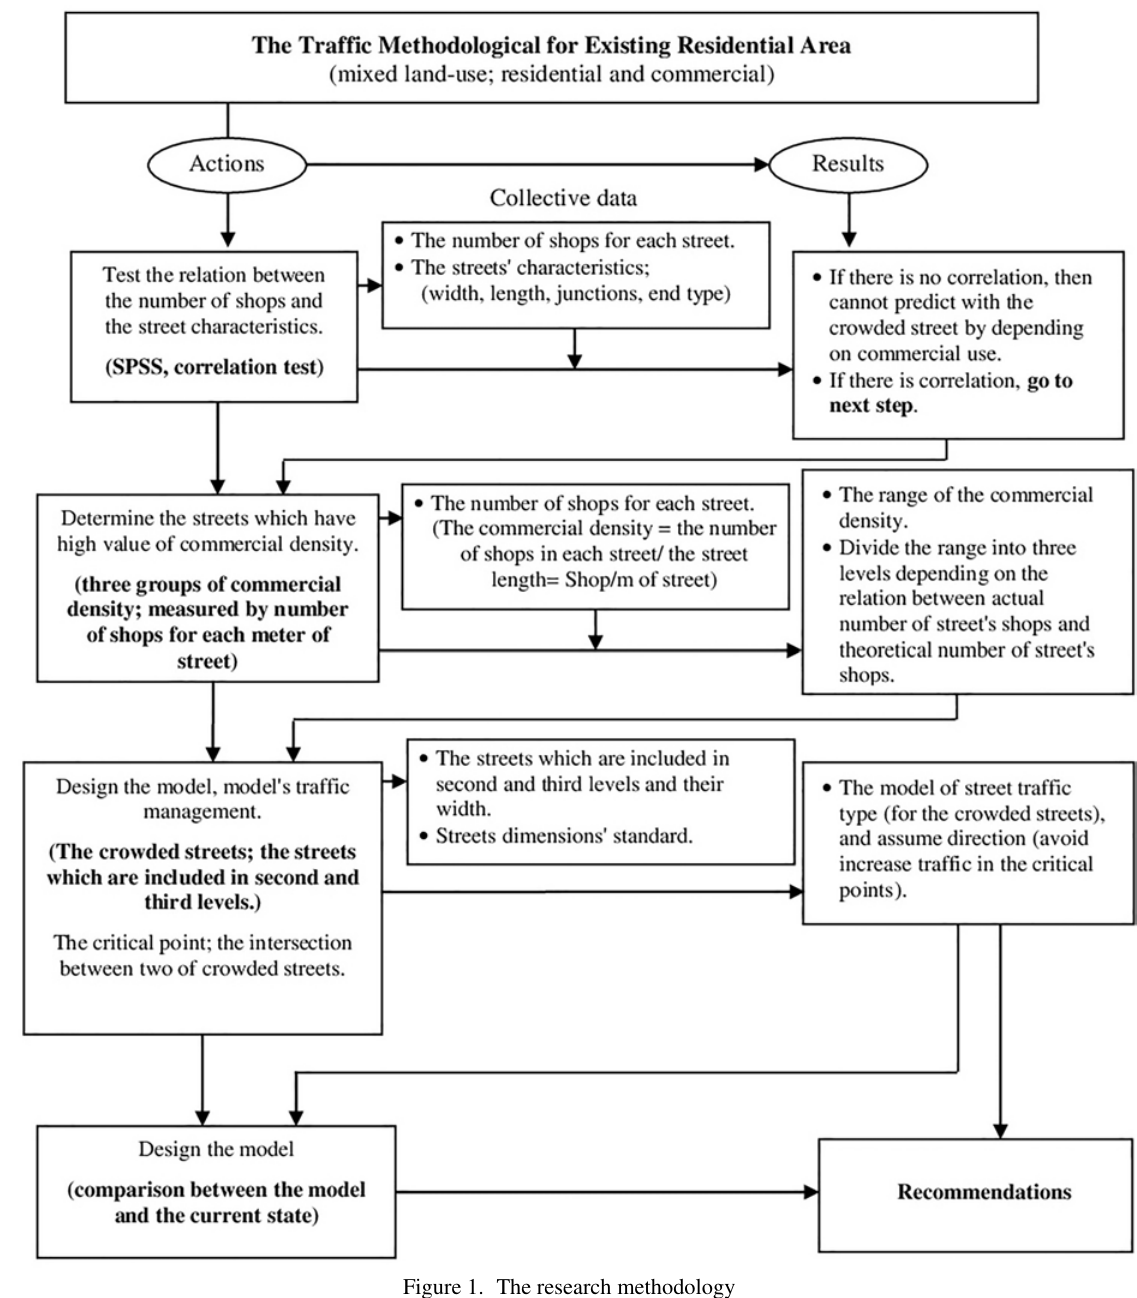
Figure 1. The research